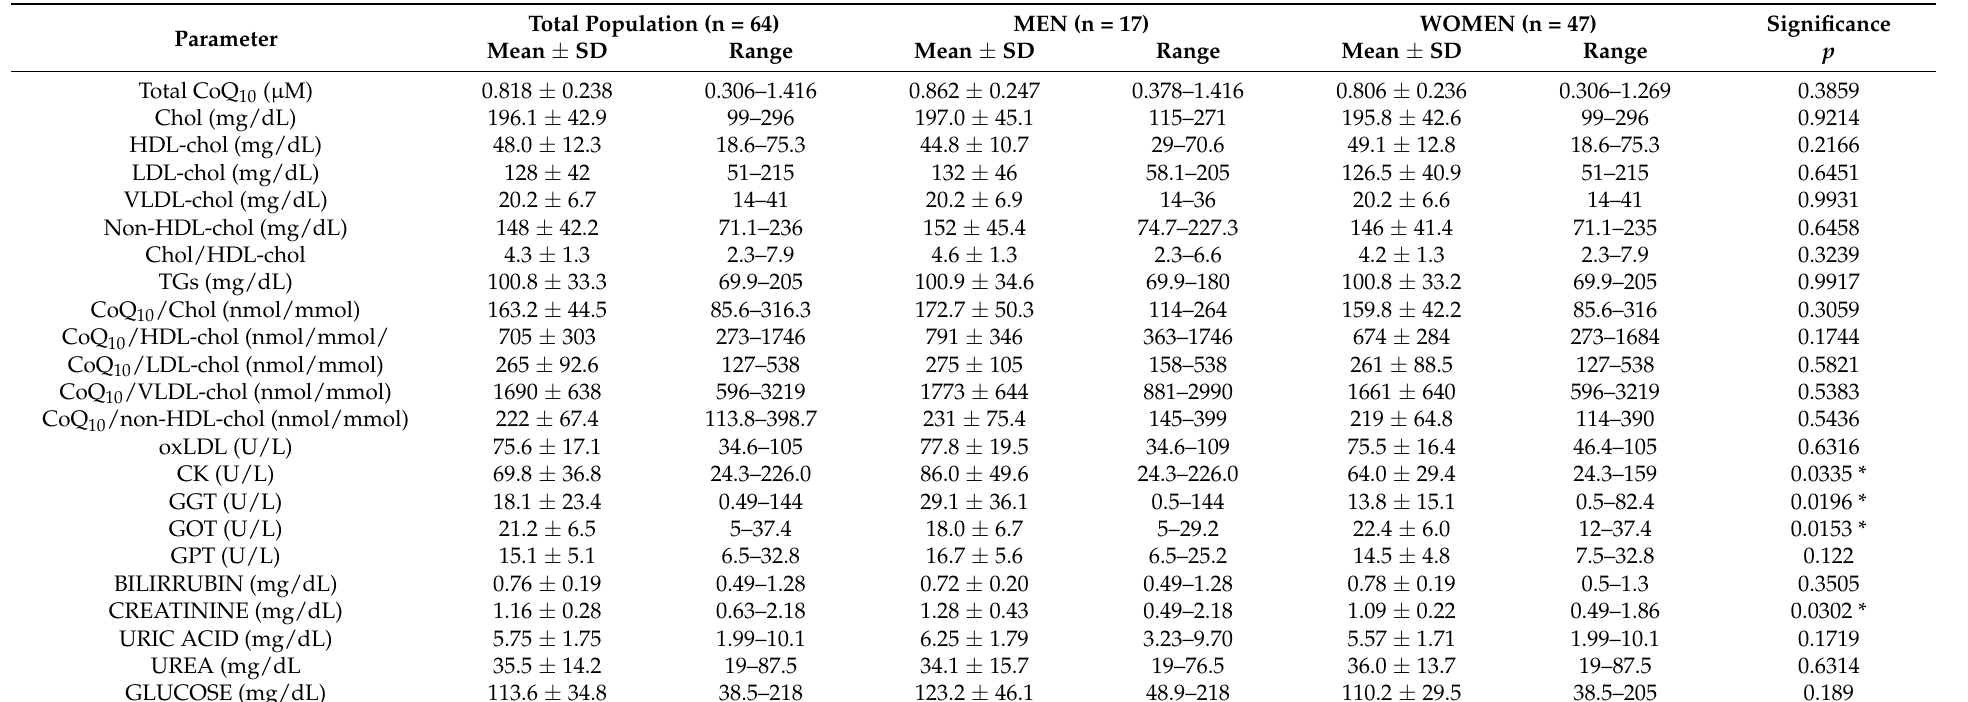
Table 3. Blood plasma biochemical parameters of the participants in this